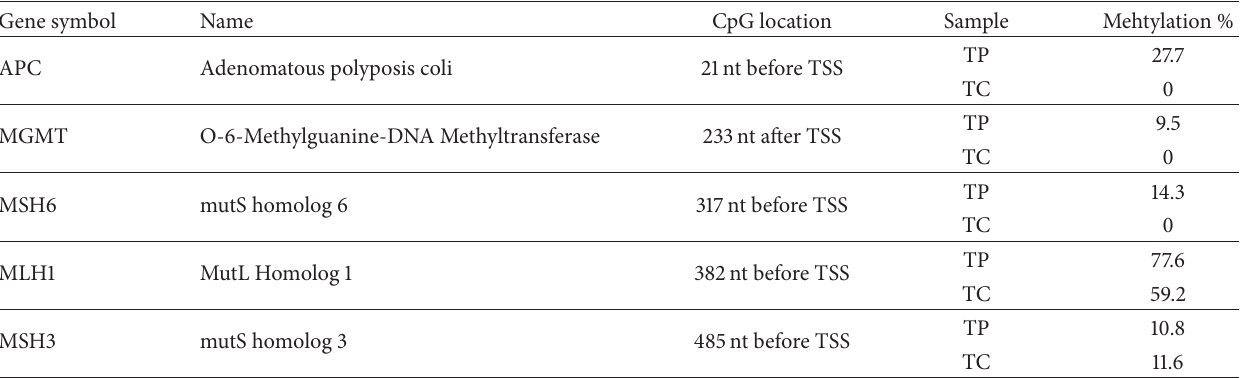
Table 2: List of methylated genes in the gastric leiomyoma studied. Gene names and gene symbols are according to the HGNC database; CpG site locations are mentioned based on the MRC-Holland data sheets. TP indicates tumor periphery and TC tumor